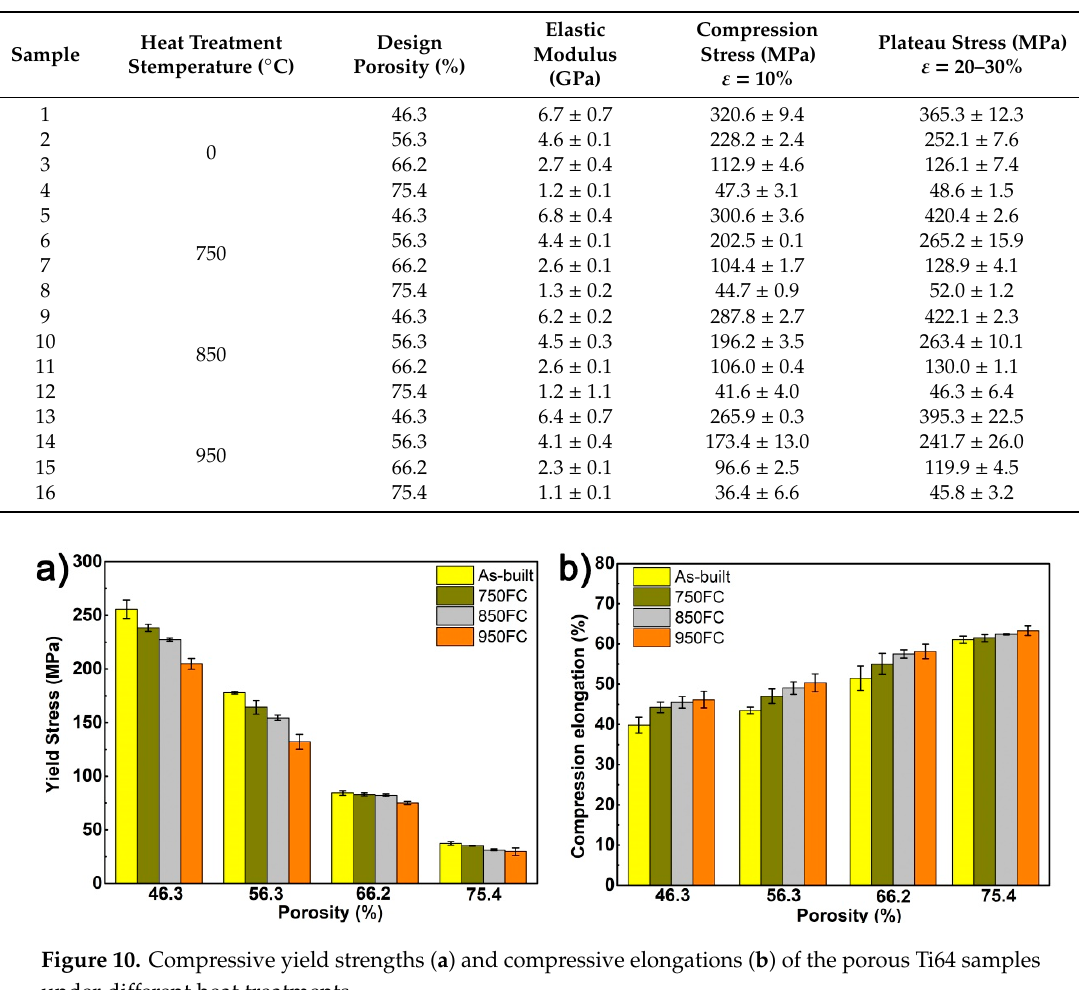
Table 3. Mechanical properties of porous Ti64 structure after di ff erent heat treatments. Sample